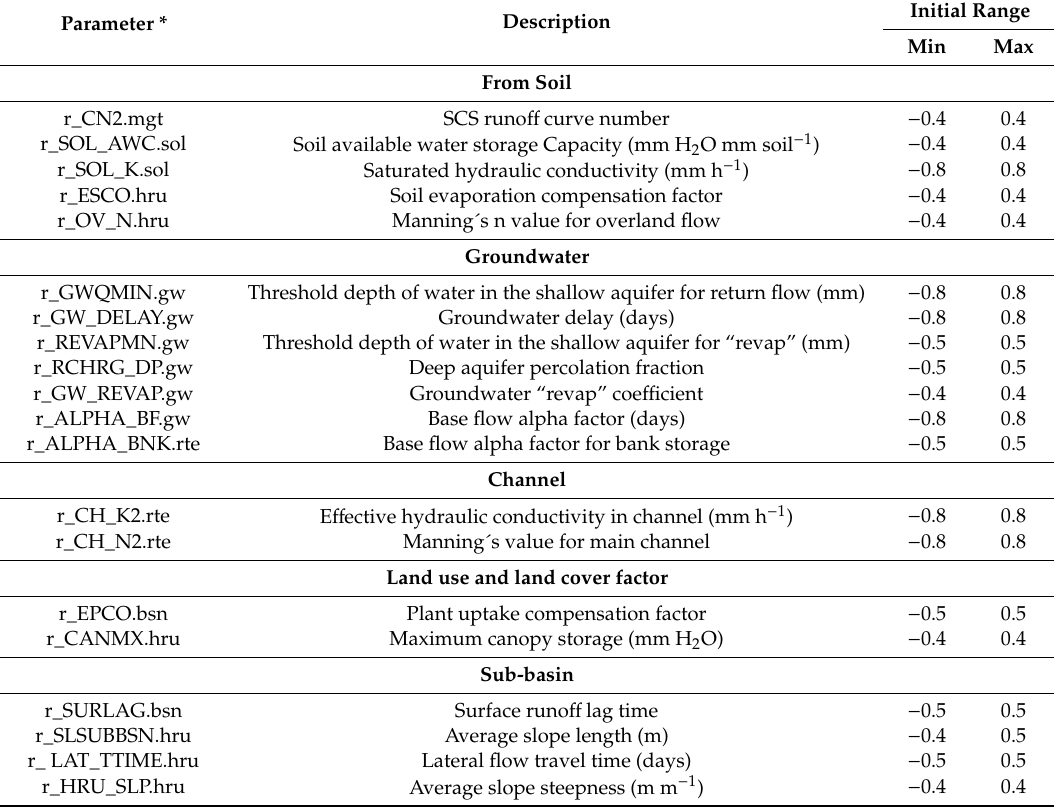
Table 1. List of sensitive parameters selected for